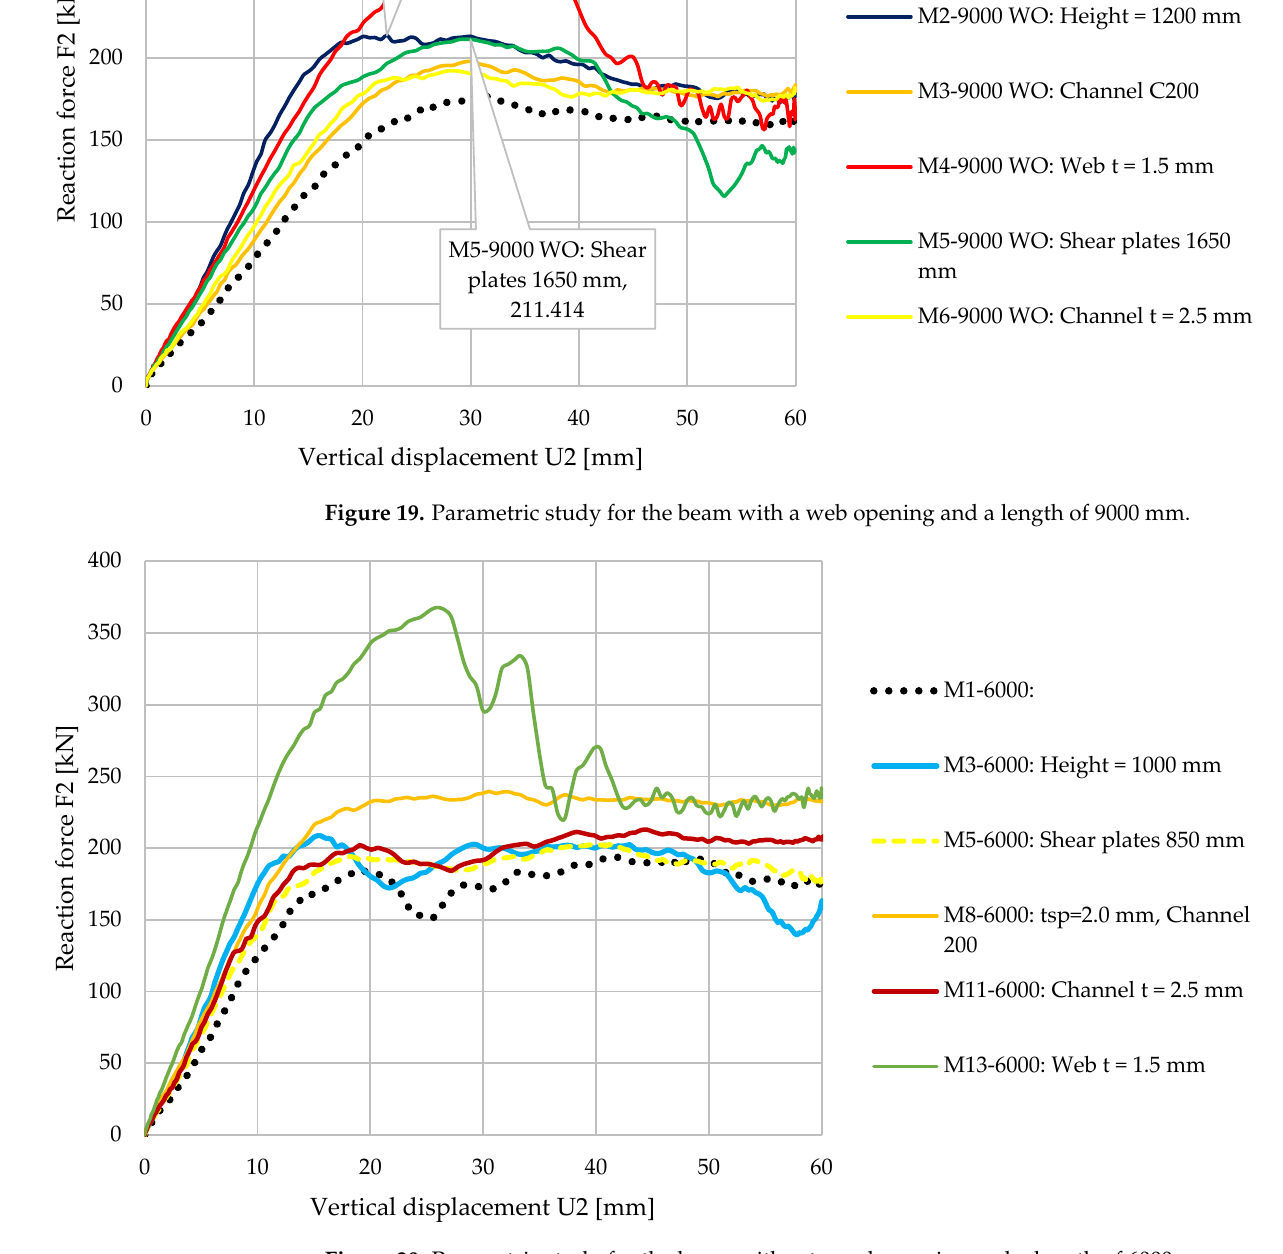
Figure 20. Parametric study for the beam without a web opening and a length of 6000 mm.